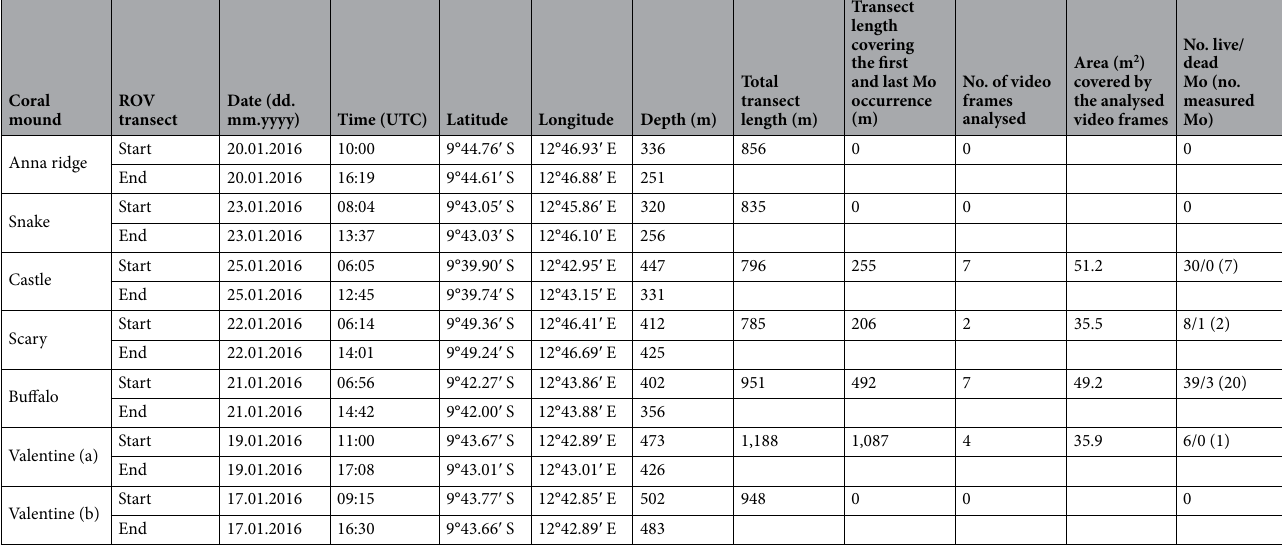
(Table 3). Consistently, M. oculata colonies could not be located on the shallow Anna ridge and Snake mound (250–330 m water depth).